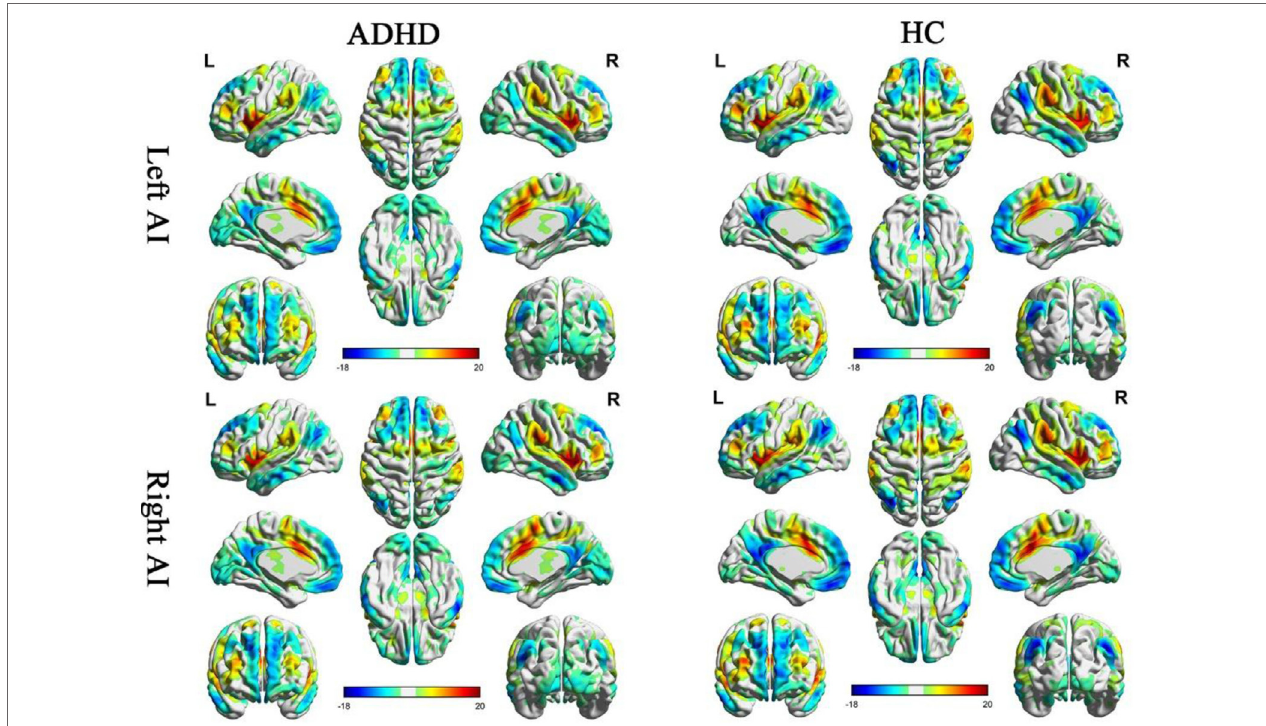
FigUre 1 | Significant resting-state functional connectivity (RSFC) patterns of the bilateral anterior insula of the attention deficit/hyperactivity disorder (ADHD) and healthy control (HC) groups. The yellow-red colors indicate that the brain regions were positively correlated with the insular subregions and the blue colors indicate that the brain regions were negatively correlated with insular subregions.